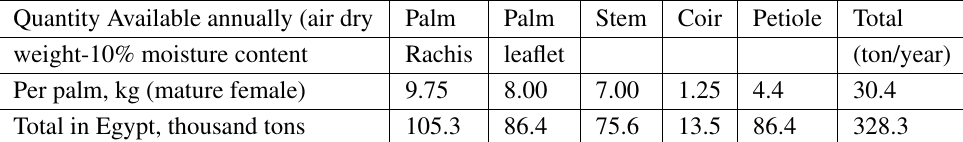
Table 1. Statistics of Date Palm Pruning Residuesin Egypt (Elmously, 2005)